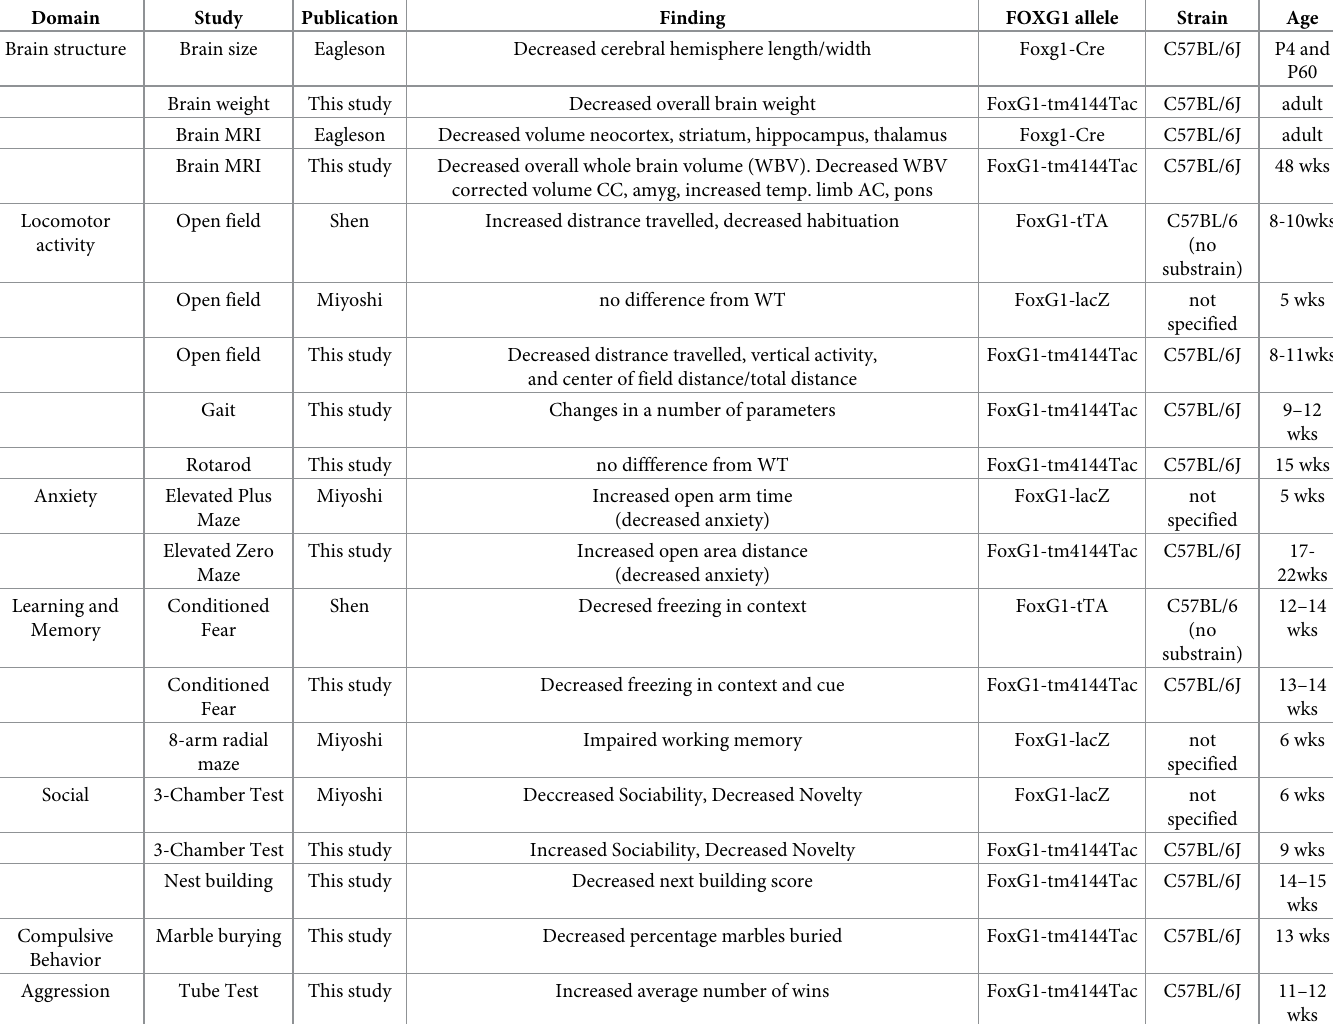
Table 4. Summary and comparison of phenotypes observed to previous published findings. CC = corpus callosum, AC = anterior commissure, amyg = amygdala. Ref- erences: Eagleson [15], Shen [16], Miyoshi [14].